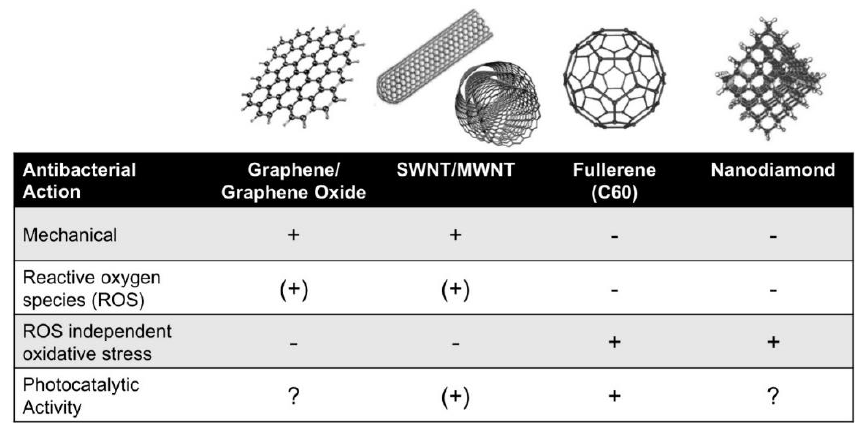
Figure 1. The different allotropes of nanocarbon and their antibacterial action (adapted from [13], with permission from the American Chemical Society 2008).